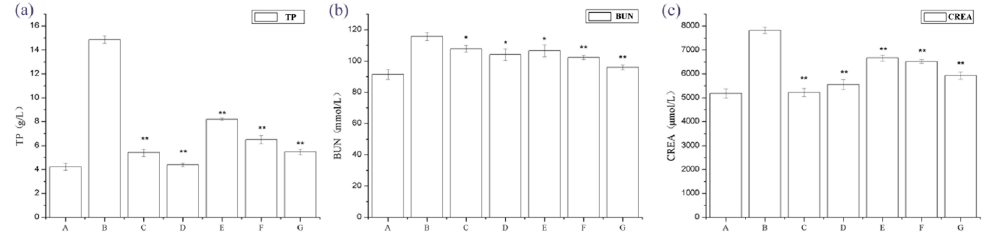
Figure 1. Changes in 24 h urine protein, blood urea nitrogen (BUN), and serum creatinine (Scr) levels. * p < 0.05, ** p < 0.01 compared to the immunoglobulin A nephropathy (IgAN) model group. A: Normal, healthy controls; B: IgAN rat models; C: prednisone acetate group (PAG); D: tripterygium glycoside tablet group; E–G: treatment group that received 0.5, 1, and 2 g/kg periostracum cicadae, respectively.